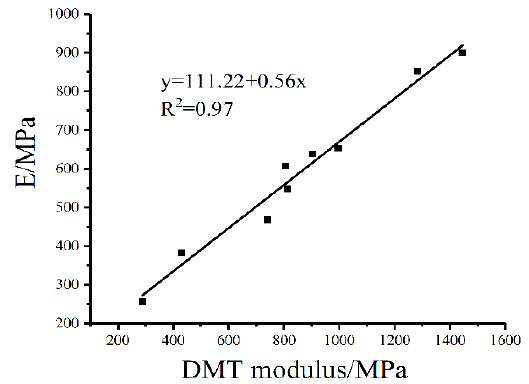
Figure 10. Relationship between the DMT modulus and E.